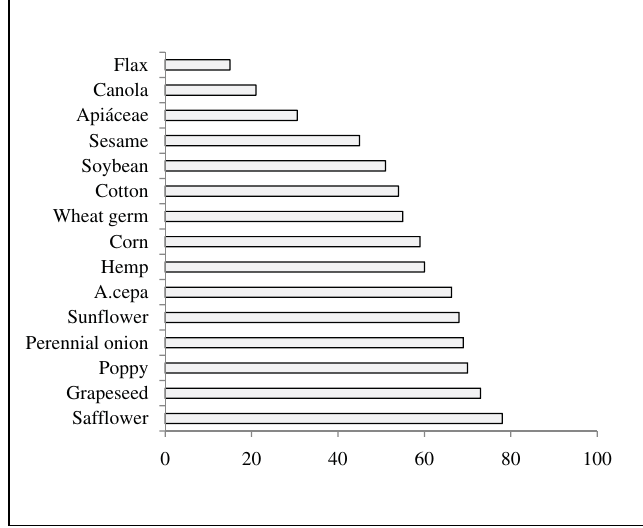
Fig. 5 - Content (%) of oleic acid in several natural